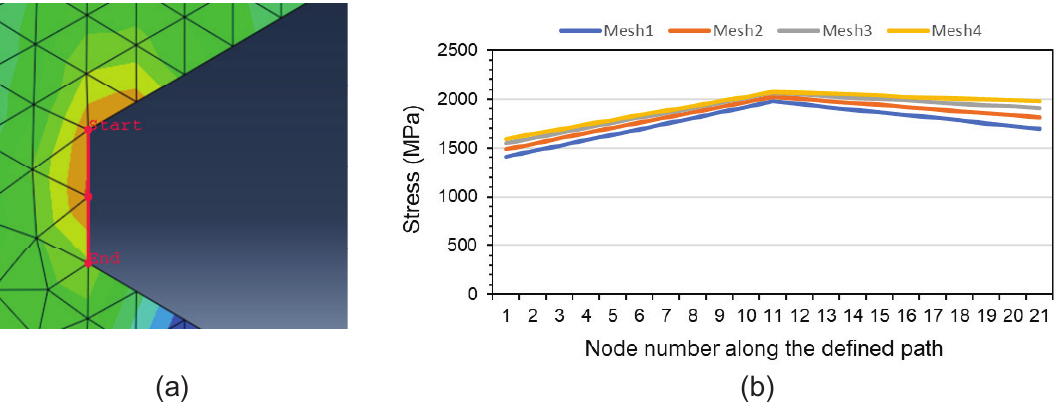
Figure 4. ( a ) The defined path along the root of the first engaged thread; ( b ) mesh sensitivity analysis results.